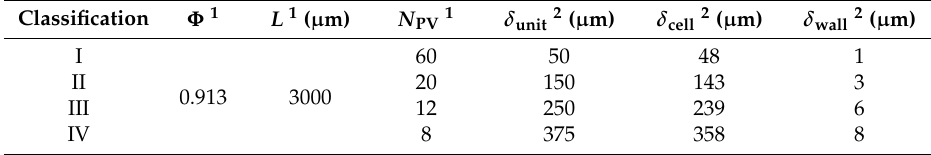
Table 5. Geometric variables used in the supplementary FEA simulations.